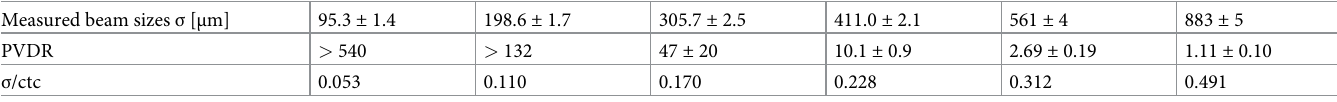
Table 2. Measured beam sizes (i.e. standard